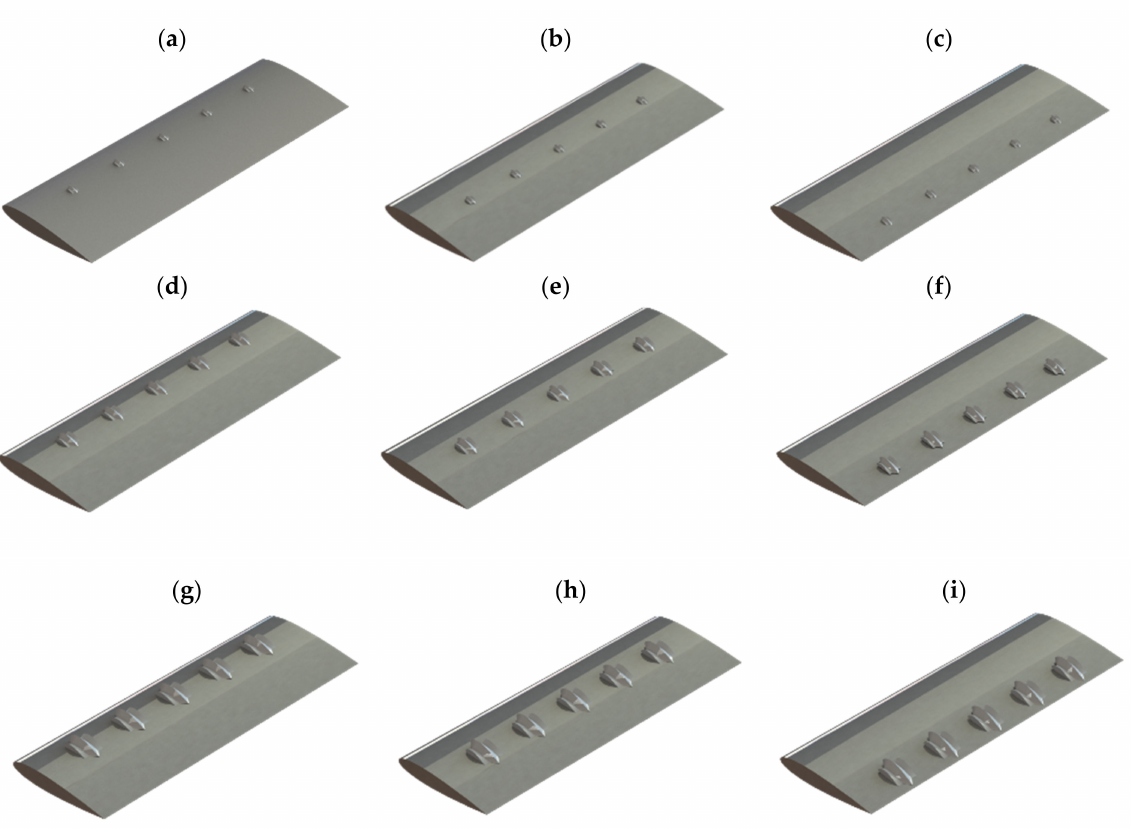
Figure 9. A schematic representation of 5S type SSVG ( a – c ), 5M type SSVG ( d – f ), and 5L type SSVG ( g – i ) blended over the test airfoil at various chordwise